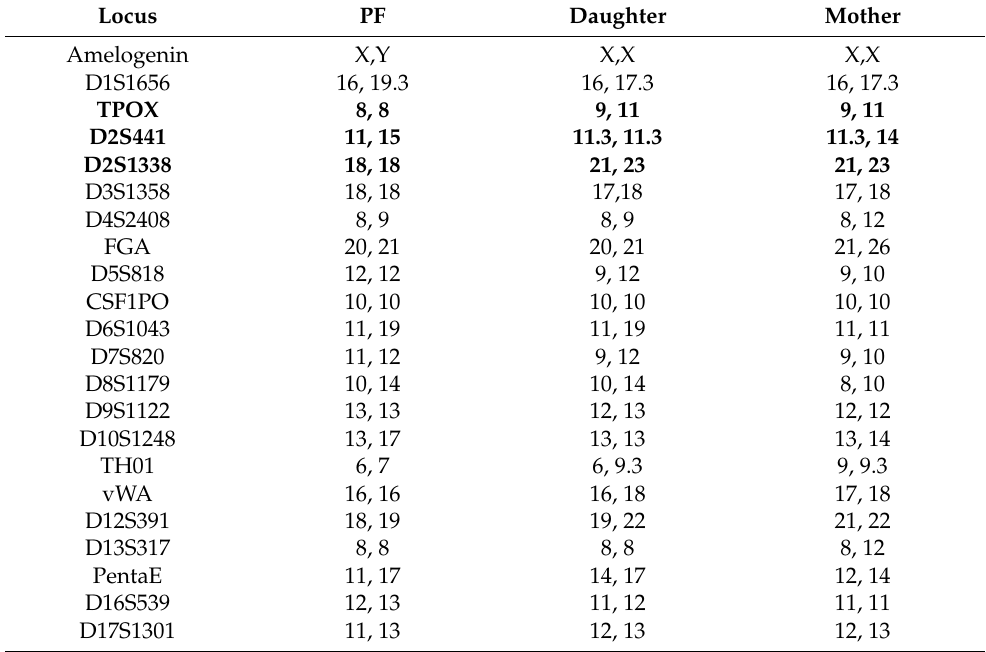
Table A1. Summary of obtained STR genotypes using NGM, GlobalFiler, HDplex, and NGS (AF— alleged father). The four bolded loci are located at chromosome 2 and indicate abnormalities in Mendelian inheritance. Locus PF